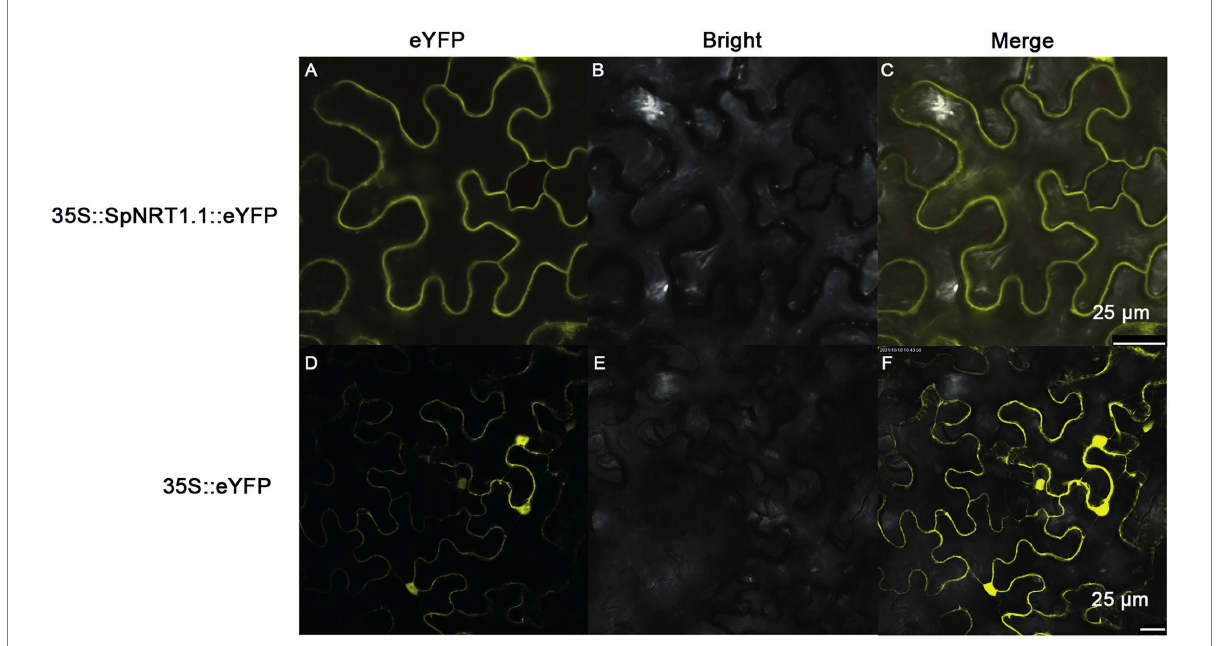
FIGURE 3 Localization of SpNRT1.1 protein in the plasma membrane of tobacco epidermal leaves. The CDS sequence of SpNRT1.1 gene fused with the eYFP sequence under the control 35S promoter was transiently expressed in tobacco leaves (A–C) , using the eYFP protein as the control (D–F) . (A,D) eYFP fluorescence; (B,E) bright field images; (C,F) merged eYFP fluorescence with bright field. Scale bar = 25 μ m.